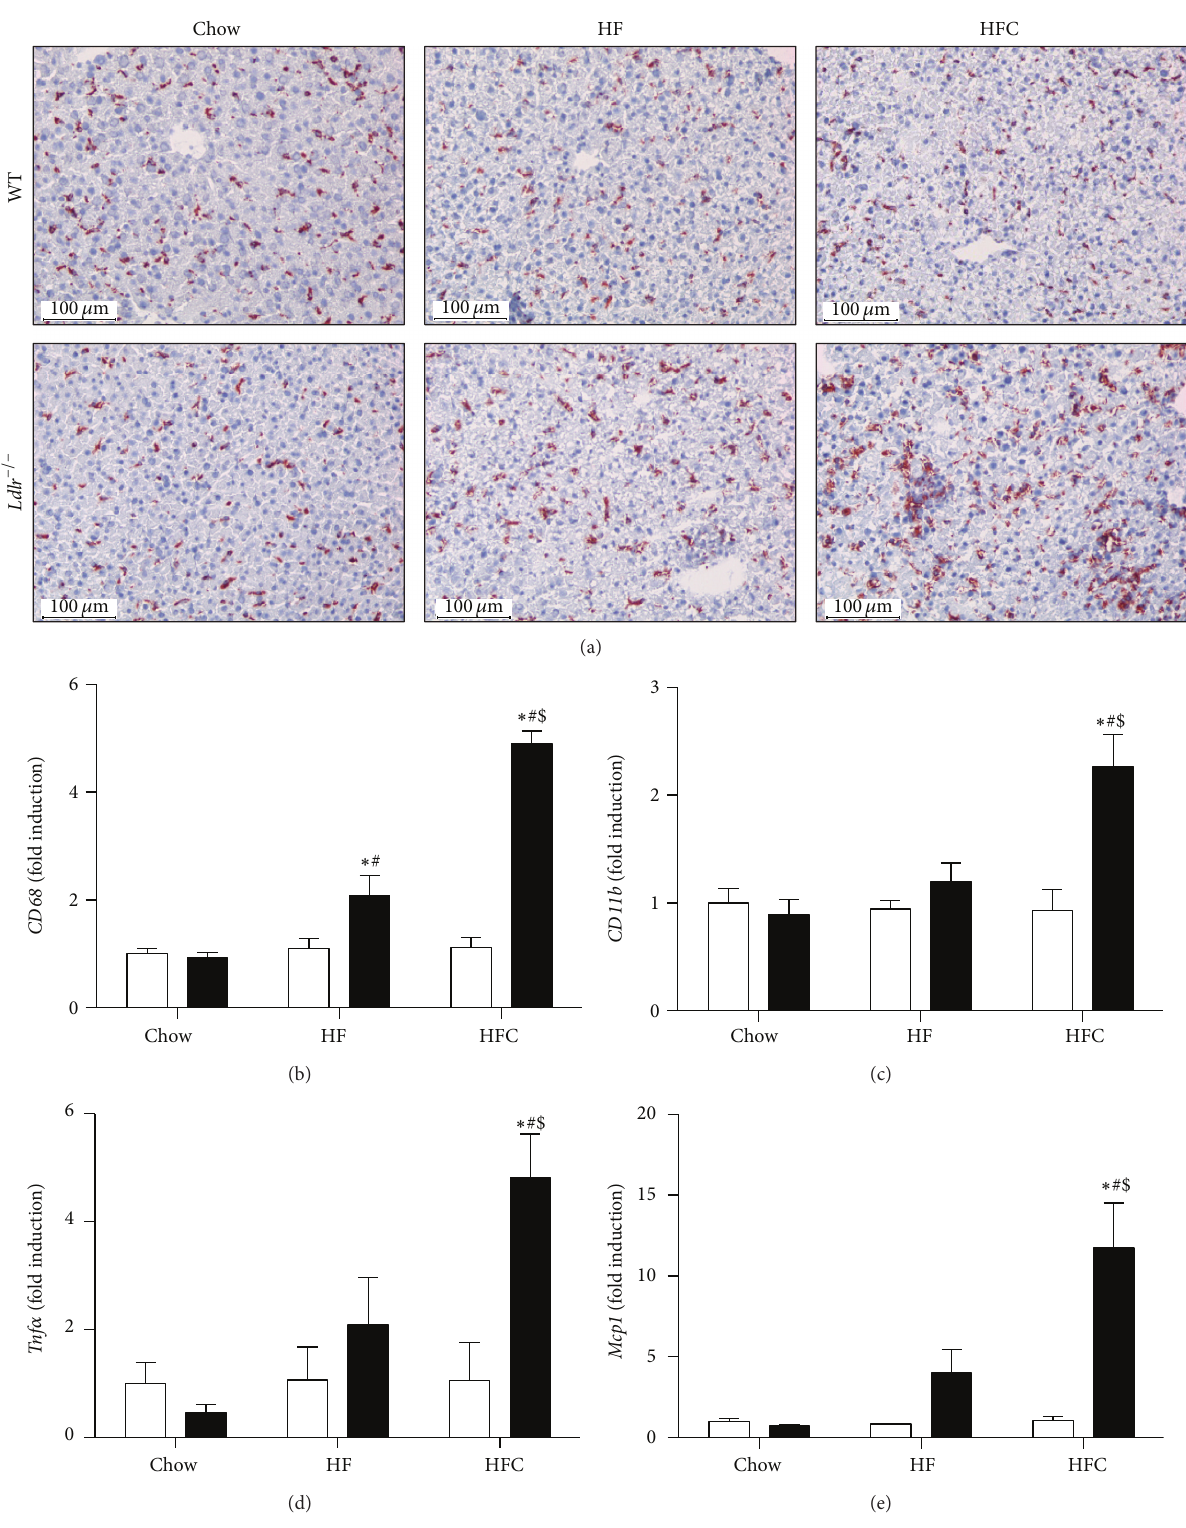
Figure 2: Hepatic inflammation in Ldlr −/− mice fed an HFC diet. (a) Representative pictures of frozen liver sections stained with CD68 were taken from WT and Ldlr −/− mice fed a chow, high-fat (HF), or high-fat cholesterol (HFC) diet ( 𝑛 = 5-6). RNA was isolated from liver tissue and the expression of the proinflammatory genes Cd68 (b), Cd11b (c), Tnfa (d), and Mcp1 (e) was determined by real-time PCR and expressed as fold induction ( 𝑛 = 5 ). Data are expressed as means ± SEM for WT mice (white bars) and Ldlr −/− mice (black bars). ∗ 𝑃 < 0.05 WT versus KO; # 𝑃 < 0.05 HF, HFC versus chow; $ 𝑃 < 0.05 , HF versus